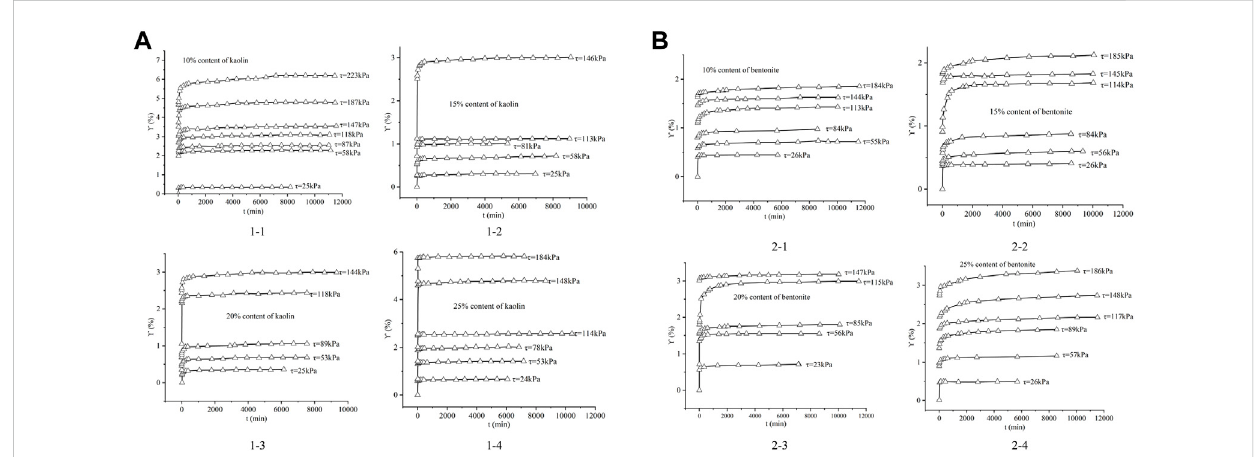
FIGURE 5 Curve of the shear rate ( γ ) with the time of each sample: (A) kaolin and (B) bentonite.